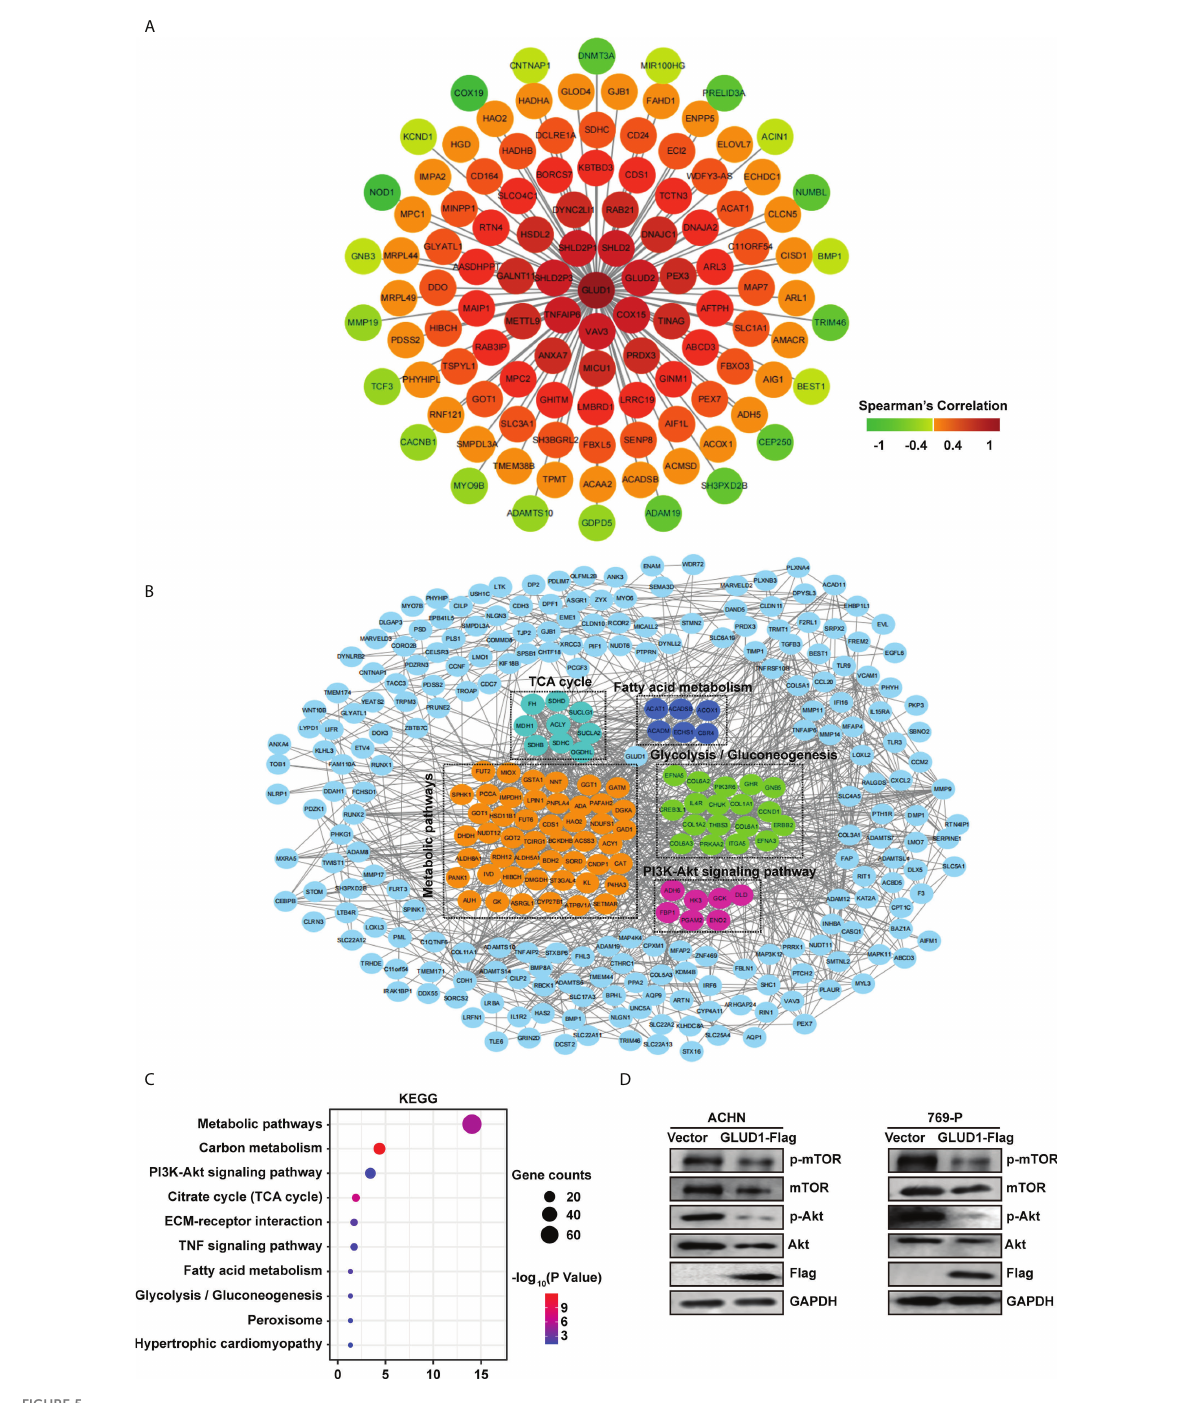
FIGURE 5 GLUD1 suppresses ccRCC tumorigenesis and development by inhibiting PI3K/Akt/mTOR pathway. (A) Co-expression network of GLUD1 gene in ccRCC. Genes that were negatively correlated with GLUD1 were displayed in green, and genes that were positively correlated with GLUD1 were displayed in red. The darker the color, the stronger the correlation. (B) PPI network of GLUD1-related DEGs. (C) KEGG pathway enrichment analysis of GLUD1-related differentially expressed proteins. (D) Western blot measured the levels of proteins related to PI3K/AKT/mTOR pathway in ACHN and 769-P cells with GLUD1